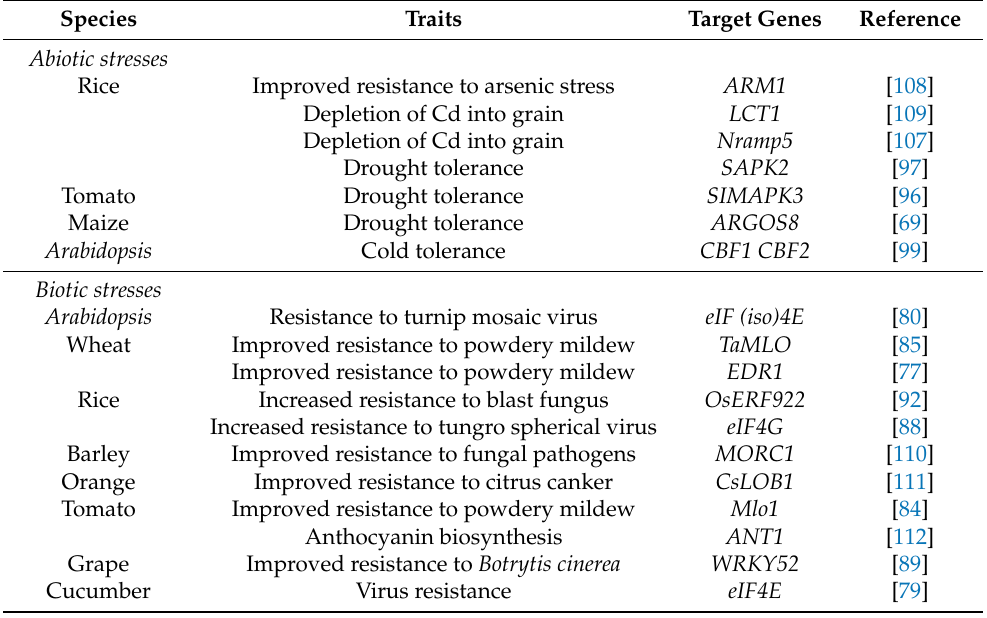
Table 2. CRISPR-Cas9 application for crop